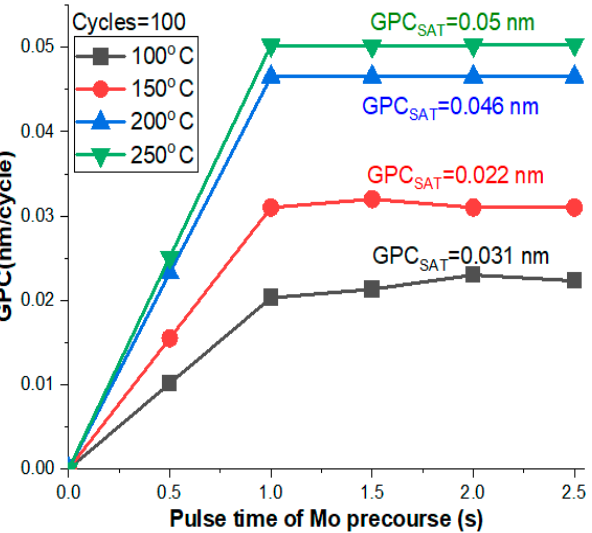
Figure 1. The GPC curves of the prepared samples at different deposition temperatures of 100, 150, 200, and 250 °C while keeping the number of cycles constant at 100.